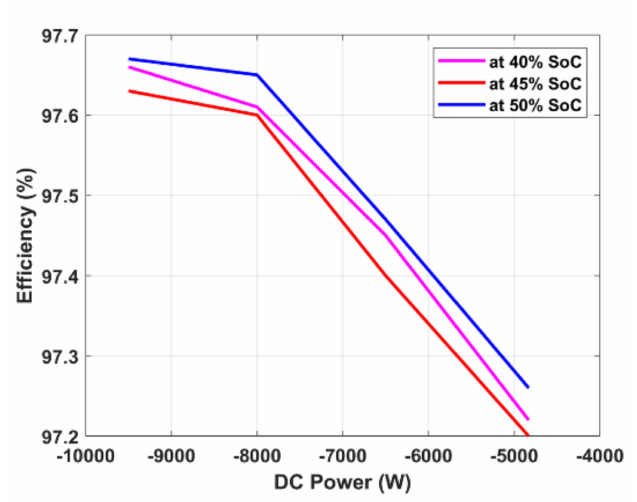
Figure 16. Estimated V2G efficiency at different initial battery SoC.